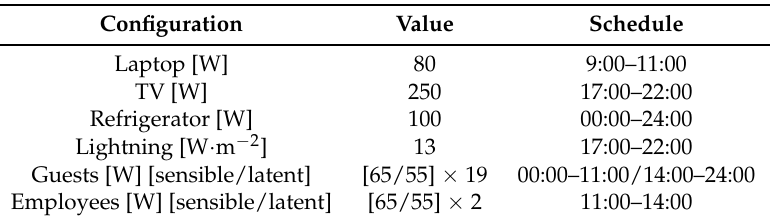
Table 4. Internal building